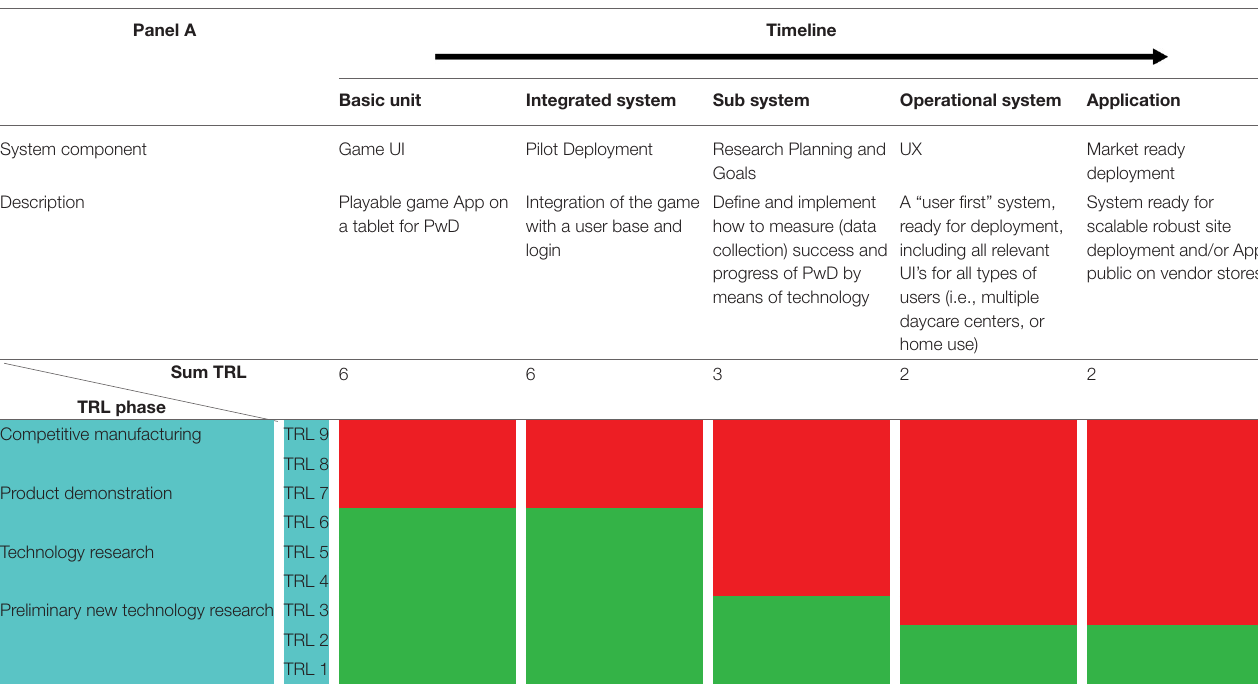
TABLE 2 | “MBW” technology readiness